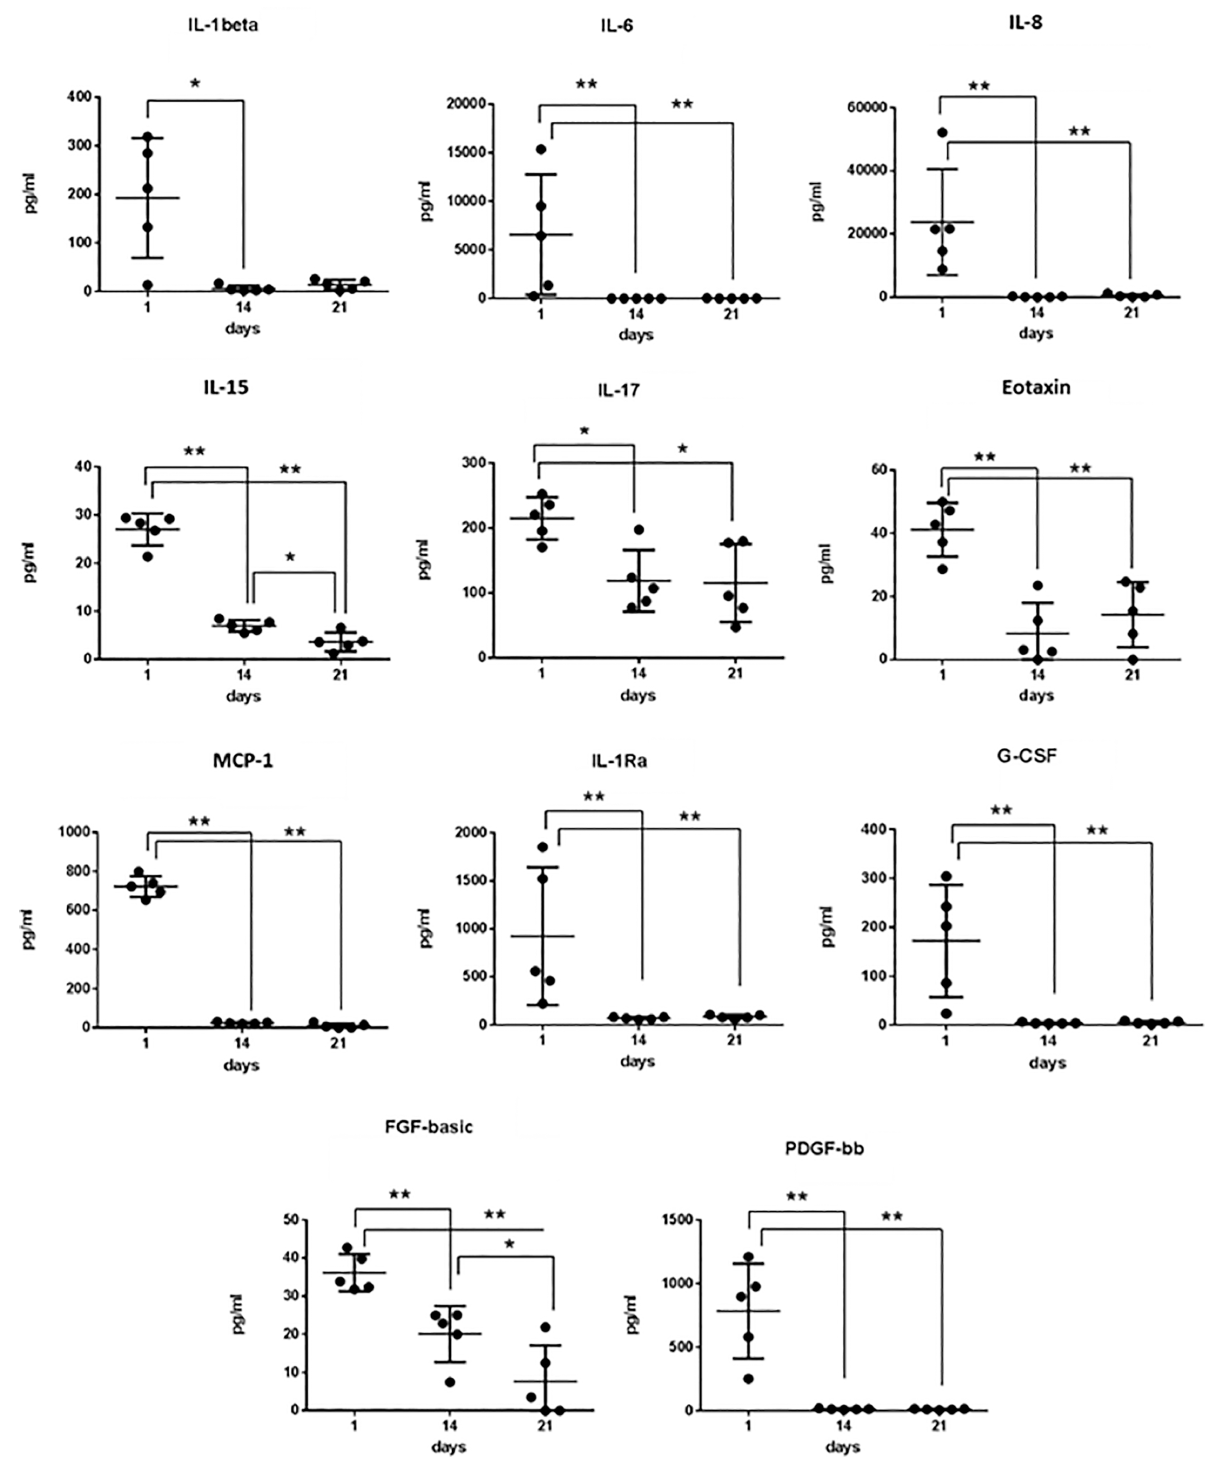
Figure 3. Secretion kinetic of patient-derived CIK cells. Cell culture supernatants were collected at the indicated time points and ana- lyzed by Bio-Plex assay. Differences between groups were considered significant when * p < 0.05 and highly significant when ** p < 0.01.